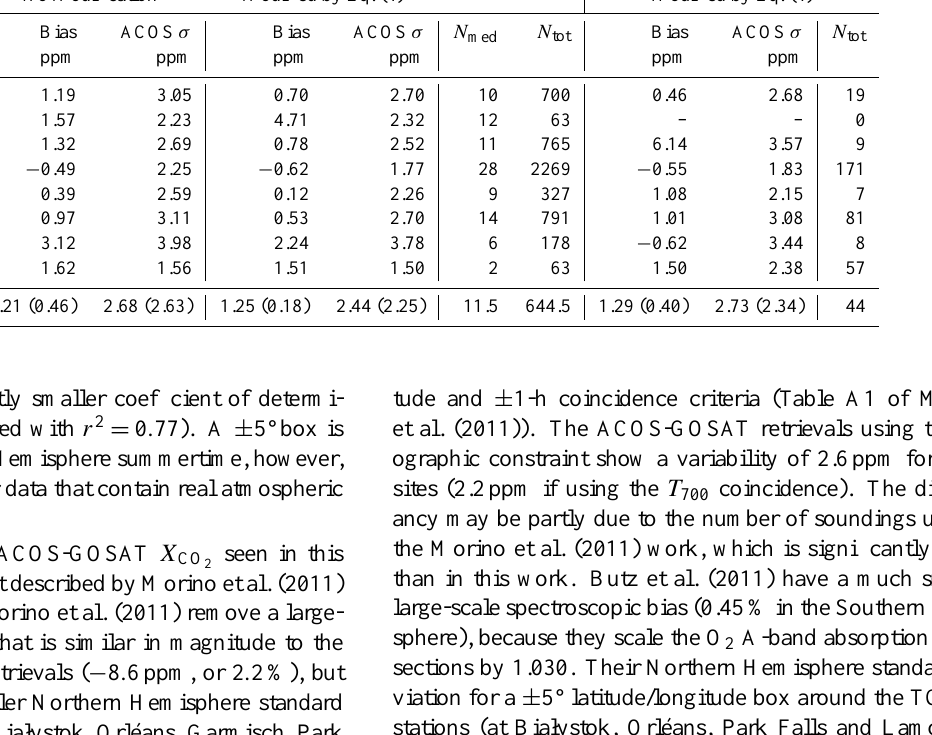
Fig. 15. A map of the areas that fulfill the coincidence criteria for a ten-day period in August, 2010. The background T 700 field is from the NCEP/NCAR analysis. The white boxes show the ± 0 . 5 ◦ latitude and ± 1 . 5 ◦ longitude limits about each TCCON site. The symbols in colour show the locations on the Earth for this ten-day period that satisfy the coincidence criteria that T 700 is within ± 2K, latitude is within ± 10 ◦ , and longitude is within ± 30 ◦ . (The only exception to this is the Tsukuba site, where the longitude criterion is tightened to ± 10 ◦ to avoid over-weighting data over China.) The actual locations of the coincidences with the ACOS-GOSAT data are restricted to the regions overlaid in colour, where the ACOS-GOSAT data exist (i.e., only over land and in cloud-free scenes). Table 3. This table presents the results of three comparisons between Northern Hemisphere TCCON X CO and the ACOS-GOSAT X CO . 2 2 Coincidence between the two datasets are determined either by the T 700 constraint (ACOS-GOSAT soundings within ± 2K, ± 10° latitude by ± 30° longitude and 10 days of a TCCON measurement), or a geographic constraint ( ± 0 . 5° latitude by ± 1 . 5° longitude). Biases are computed by subtracting the TCCON X CO from the ACOS-GOSAT X CO . The ‘No Modification’ fields include the 0.982 bias correction, 2 2 but not the regression described by equation 4. The “Modified” fields have had equation 4 applied. The “ACOS σ ” field lists the mean standard deviation of the ACOS-GOSAT data for a particular location. The column labeled “ N med ” is the median number of ACOS-GOSAT spectra involved in a single coincidence for a particular site. The columns labeled “ N tot ” are the total numbers of ACOS-GOSAT spectra involved with the comparison for all times at that site. The averages in parentheses are weighted by N tot . There are no ACOS-GOSAT data coincident with the Eureka site using the geographic constraint. T 700